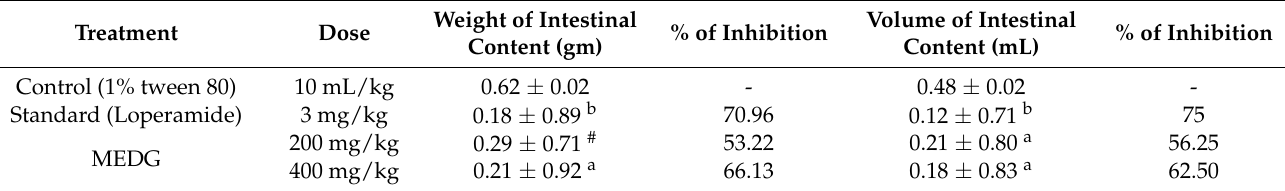
Table 3. Effects of MEDG on castor oil-induced enter pooling in mice.